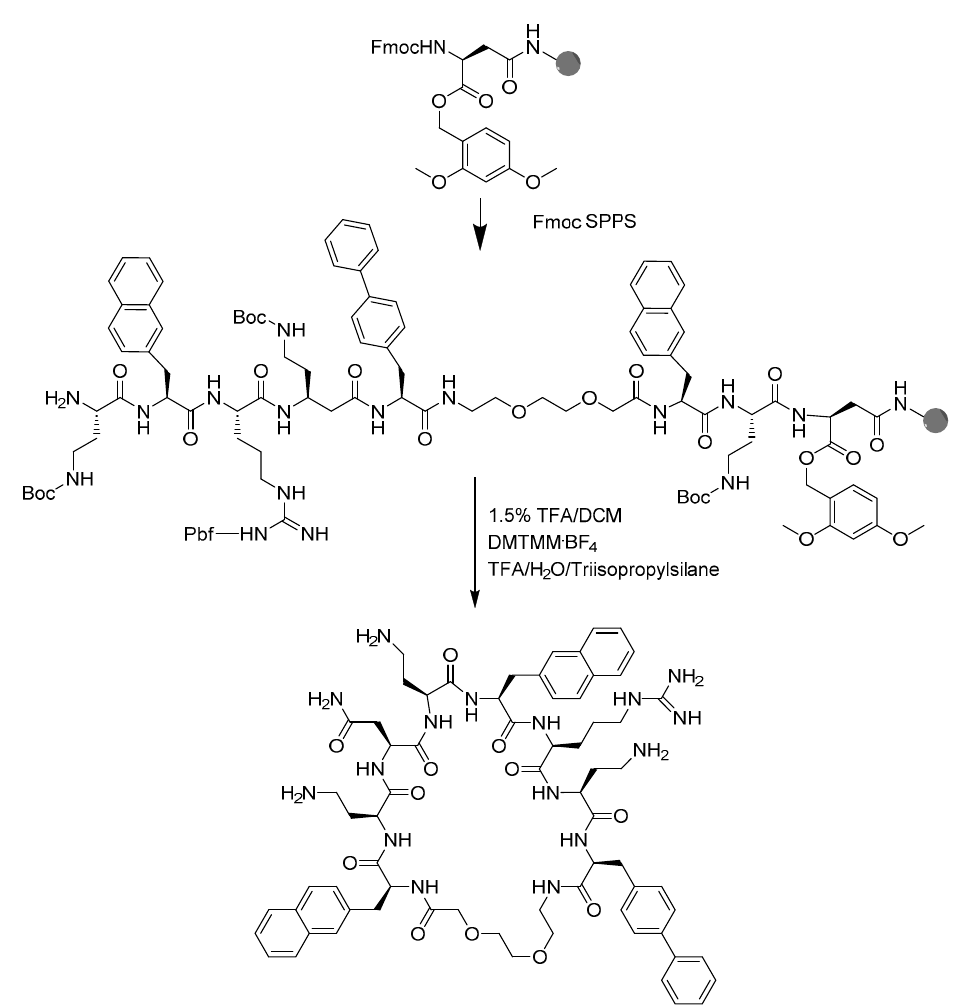
Scheme 1: Strategy for solid-phase peptide synthesis of the lead compound